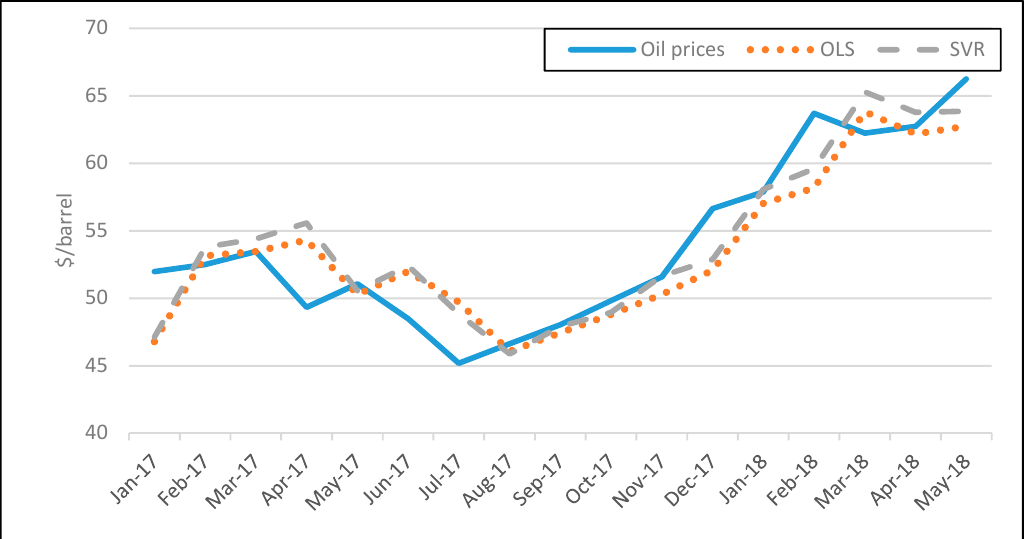
Figure 2. Out-of-sample 1-month ahead oil prices forecasts based on the Saudi Arabia geopolitical risk (GPR) index for the Support Vector Regression (SVR) and Ordinary Least Square (OLS) model for the period Jan-2017 to May-2018.